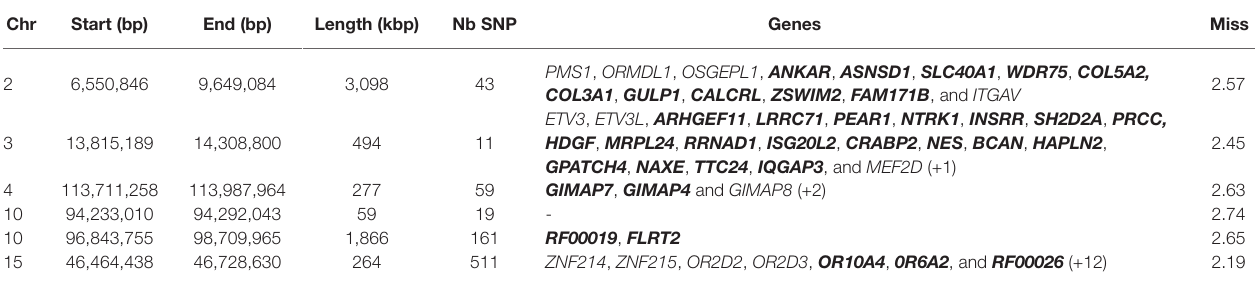
TABLE 3 | Candidate genomic regions under historical selection in Asturiana de los Valles detected by the nSL approach from SNPs genotyped in all generations. Chr